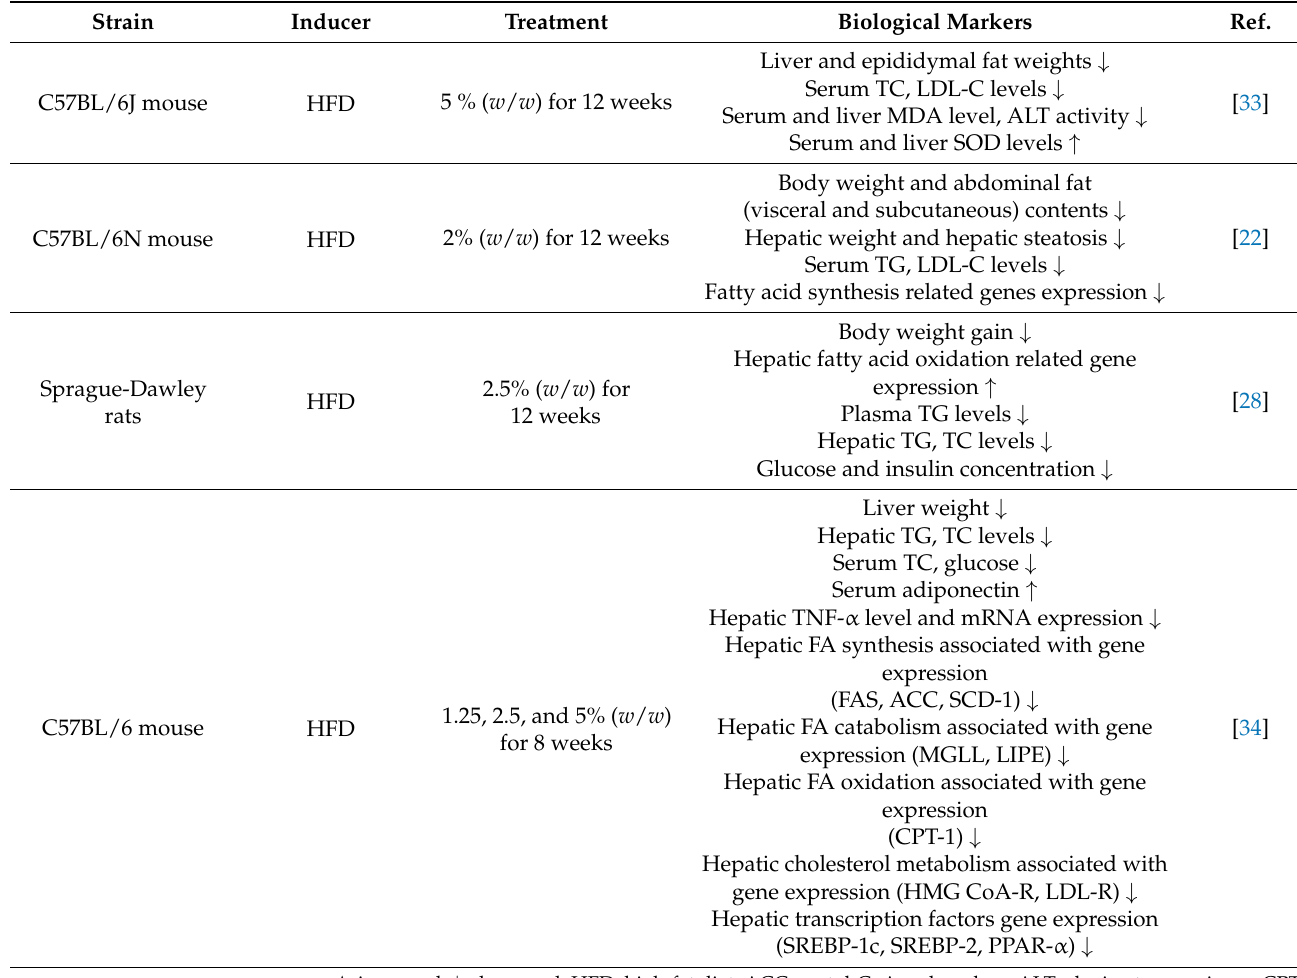
Table 6. Effects of krill oil in animal models with metabolic disease.